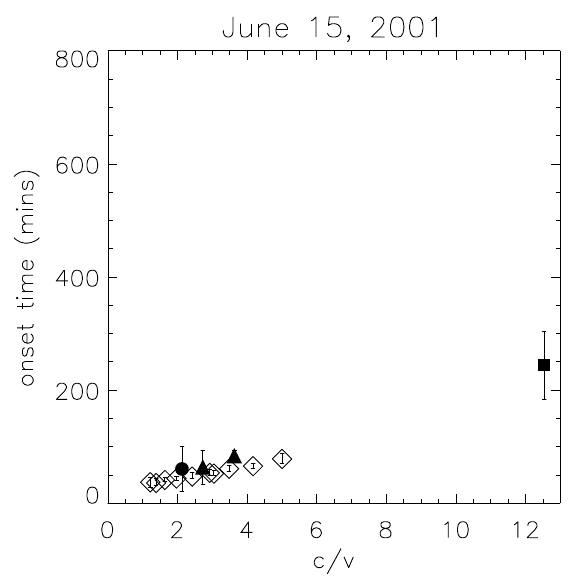
Fig. 3. Onsets at Ulysses and Wind for the 15 June 2001 event, when Ulysses was at low